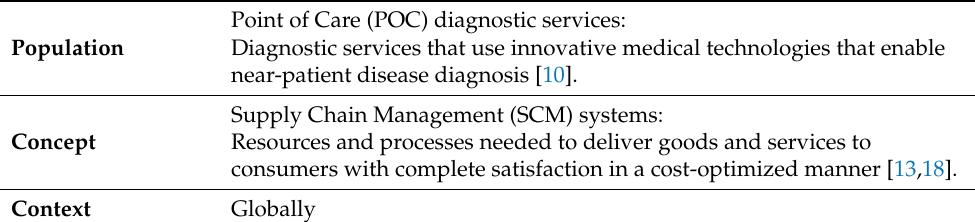
Table 1. PCC framework for determining the eligibility of the research